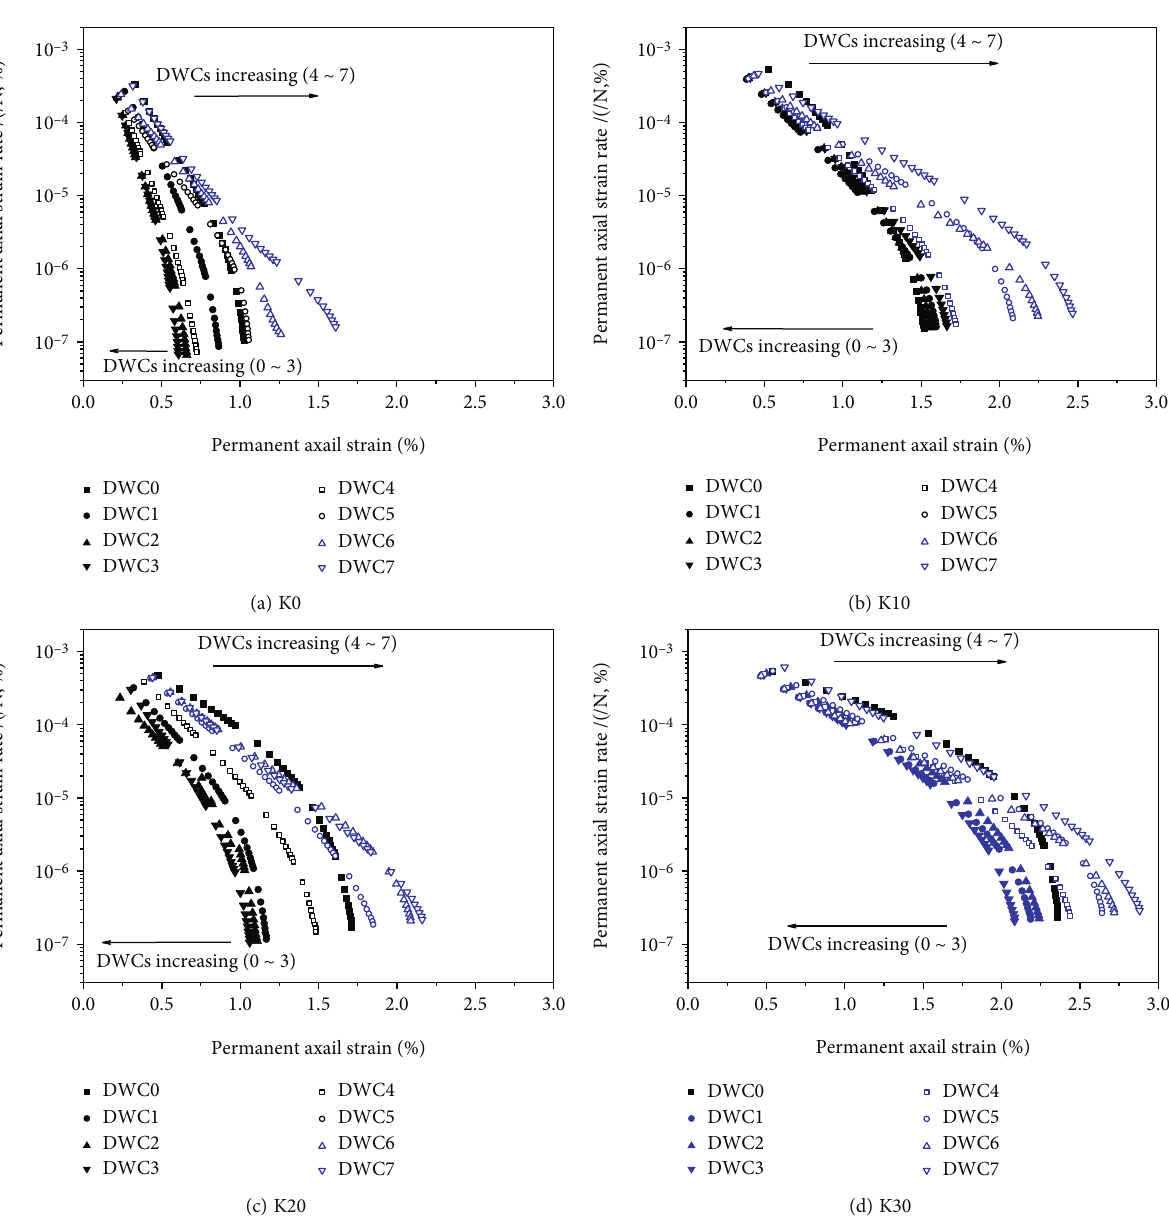
Figure 12: Permanent axial strain rate of GRS under D-W cycles in the compression stage (black points: plastic shakedown; blue points: plastic